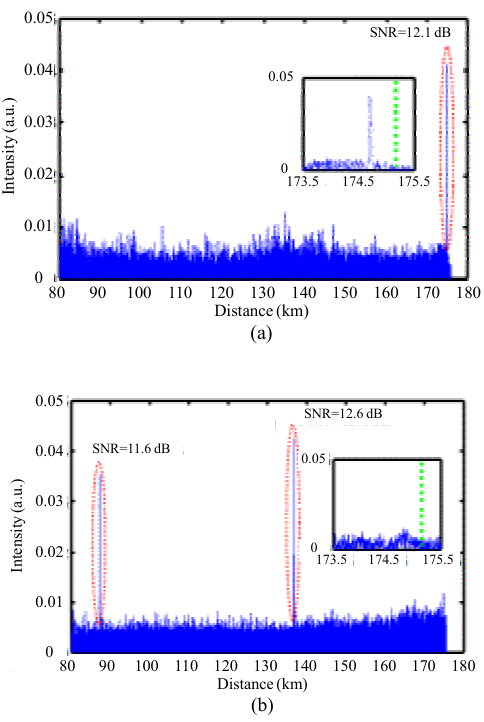
Fig. 12 Demodulated intrusion signal at different locations: (a) single-point perturbation at 174.7 km and (b) two-point perturbation at 87.3 km and 136.6 km. Insets: comparison of the signal inside the fiber and the noise outside the